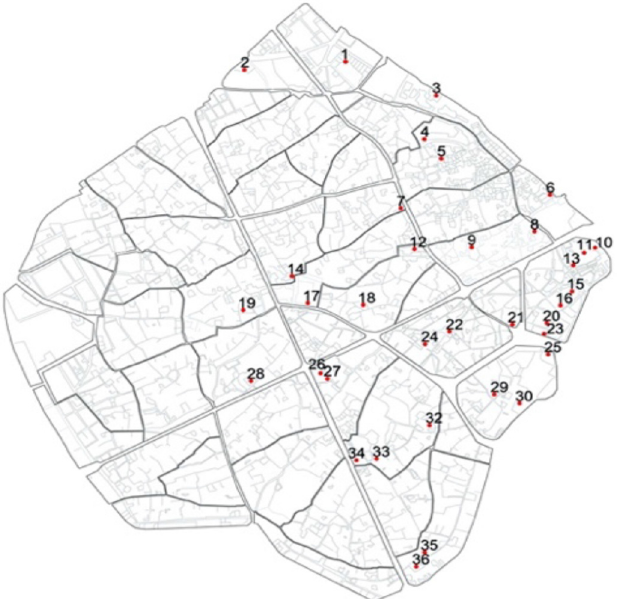
Fig. 8. Locations of the destroyed heritage landmarks. 1.